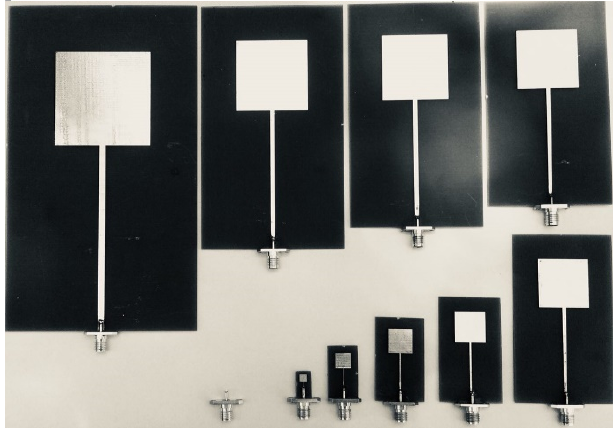
Figure. 2. Fabricated antennas with mounted SMA connector.